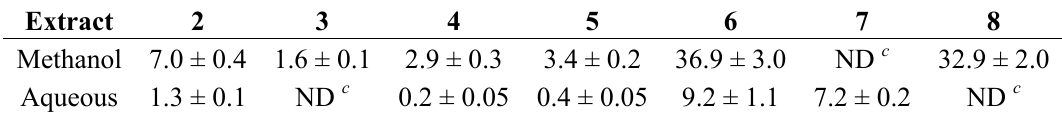
Table 6. Concentration levels a,b of compounds 2 – 8 of Scheme 3 in olive leaf extracts